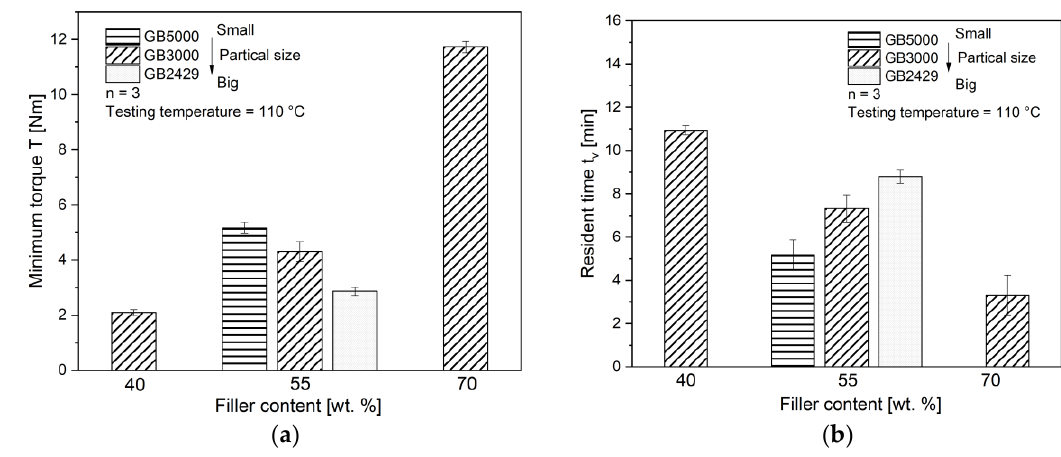
Figure 7. the measured ( a ) minimum torque T and ( b ) resident time t v of compounds. Figure 7. The measured ( a ) minimum torque T and ( b ) resident time t v of